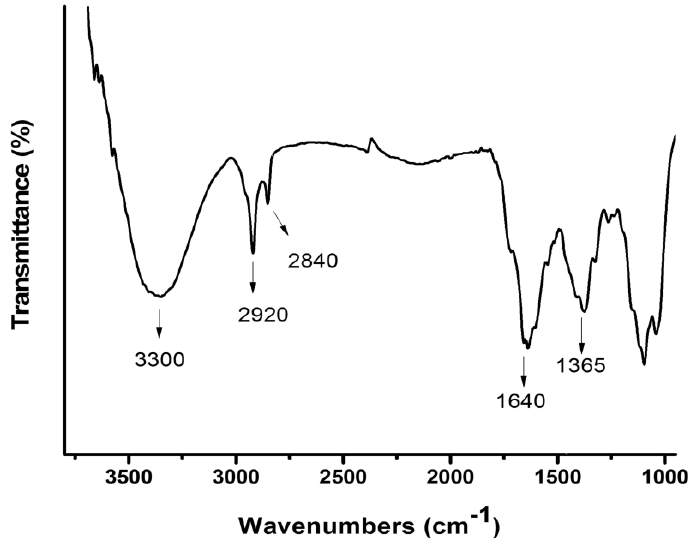
Figure 6. Typical FT-IR spectra of PMALHs.